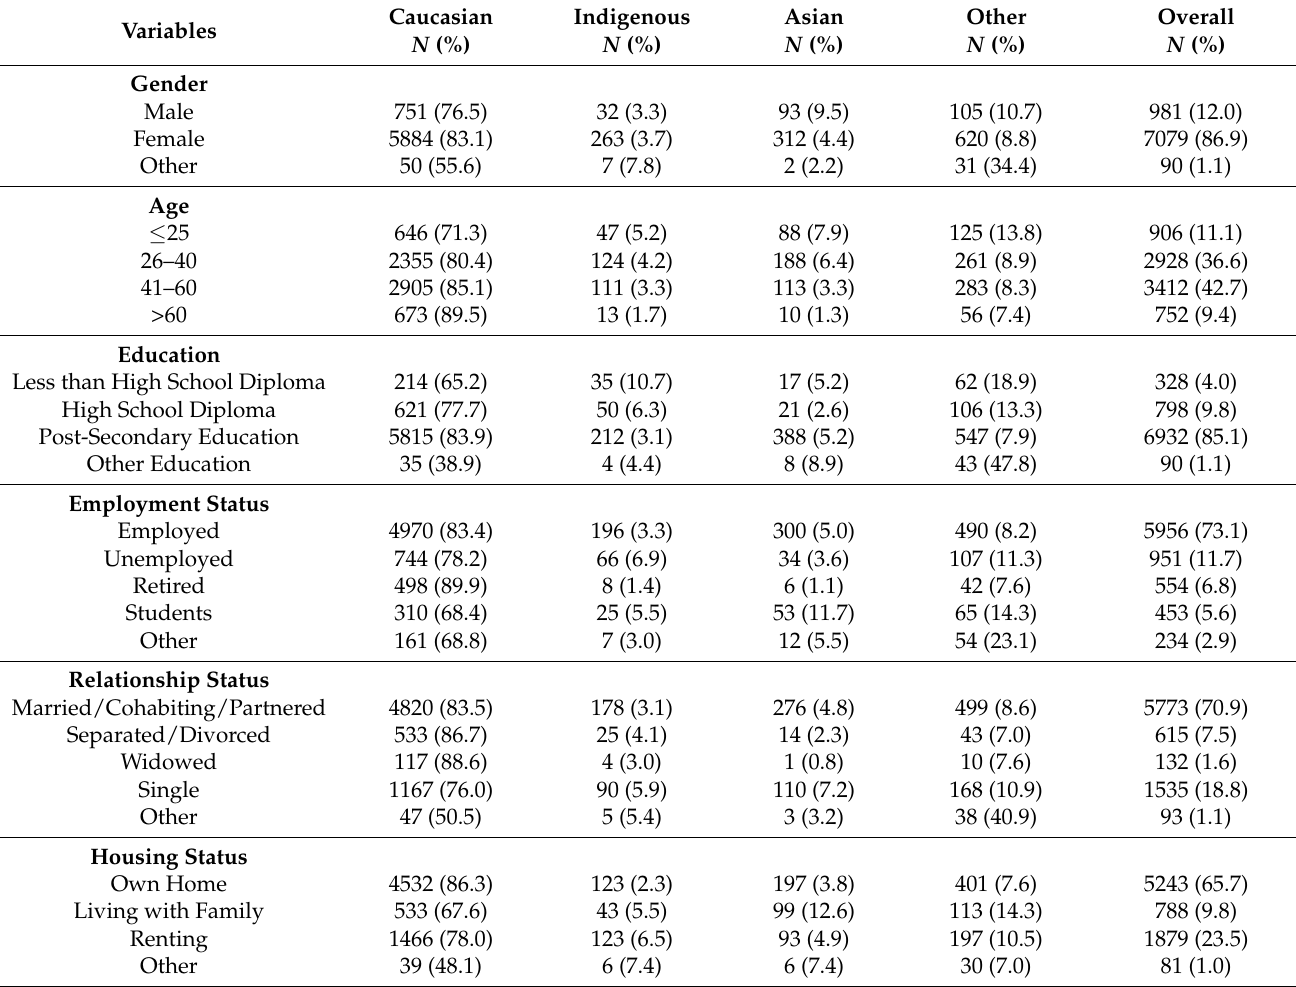
Table 1. Demographic characteristics of respondents by self-reported